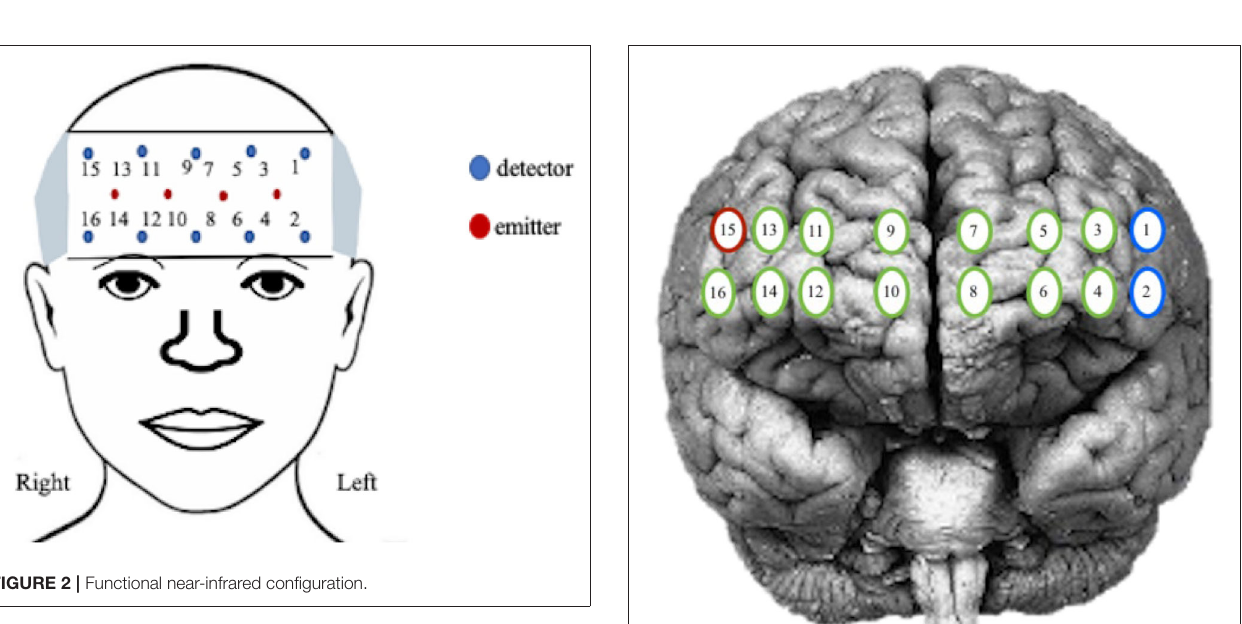
FIGURE 1 | Schematic of practice schedule according to motor learning guided treatment protocol.